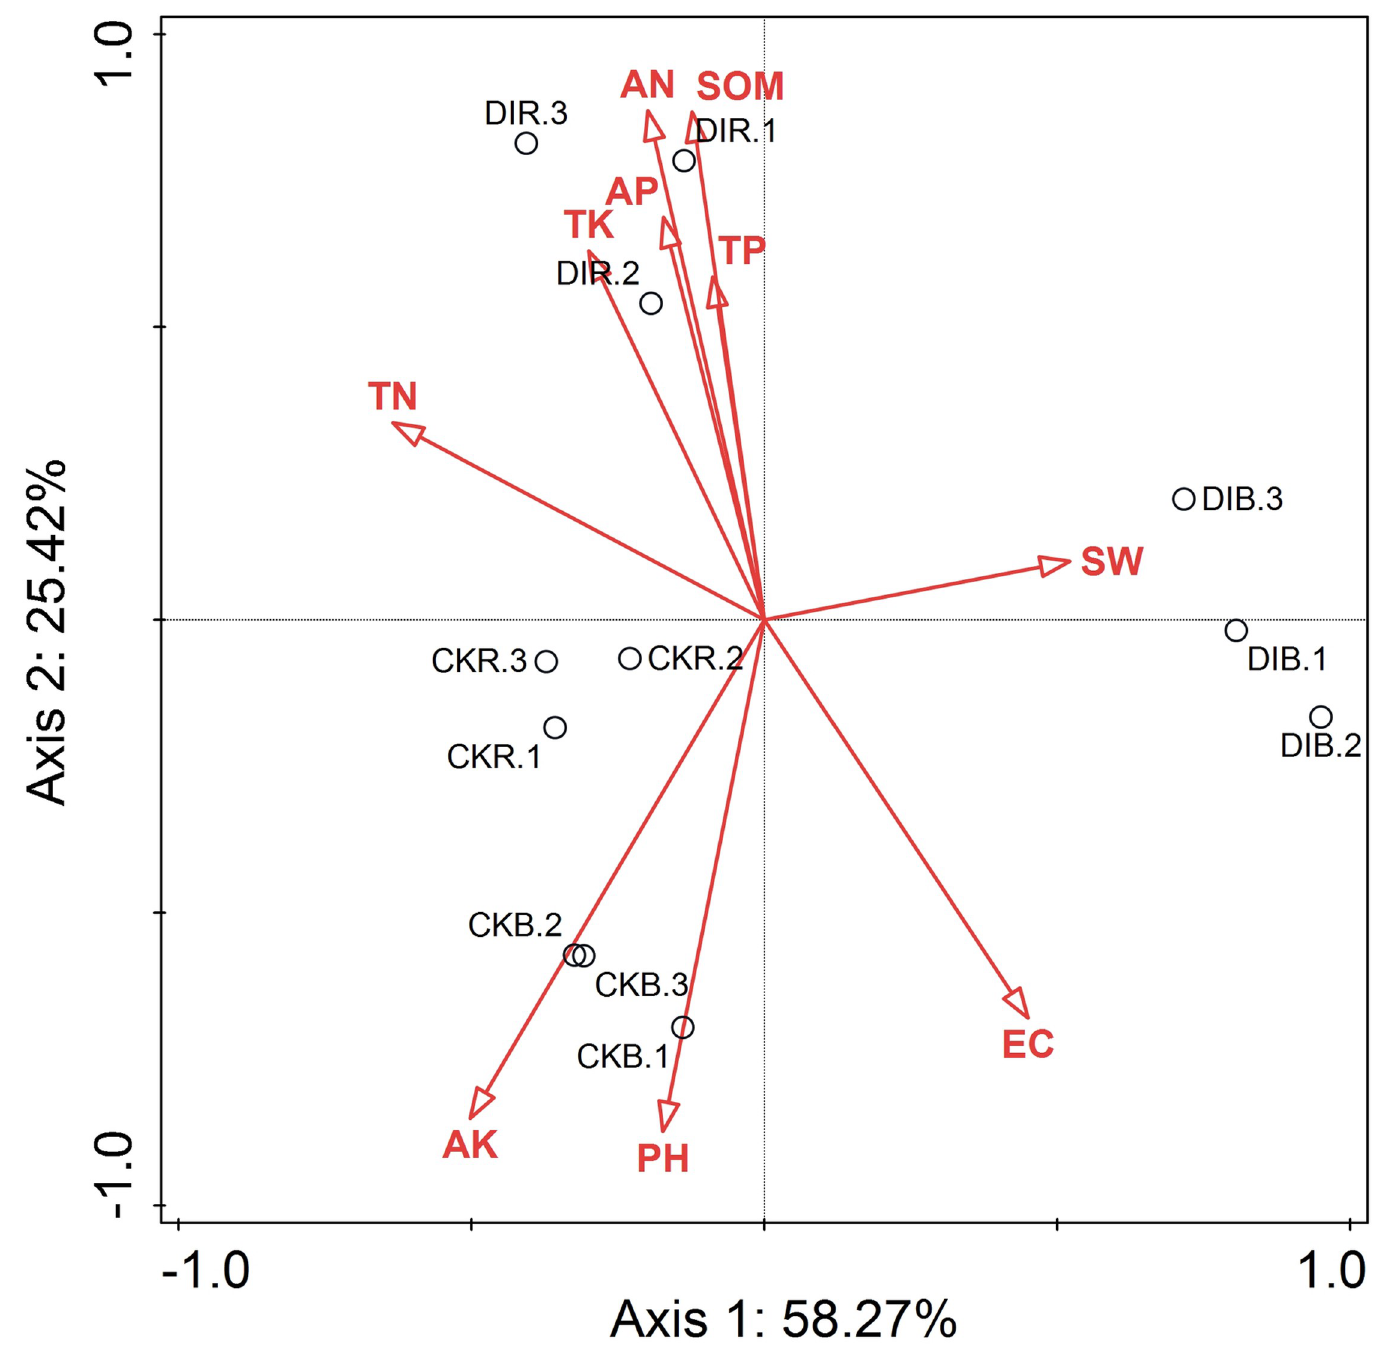
Fig 7. Redundancy analysis of soil fungal communities and environmental